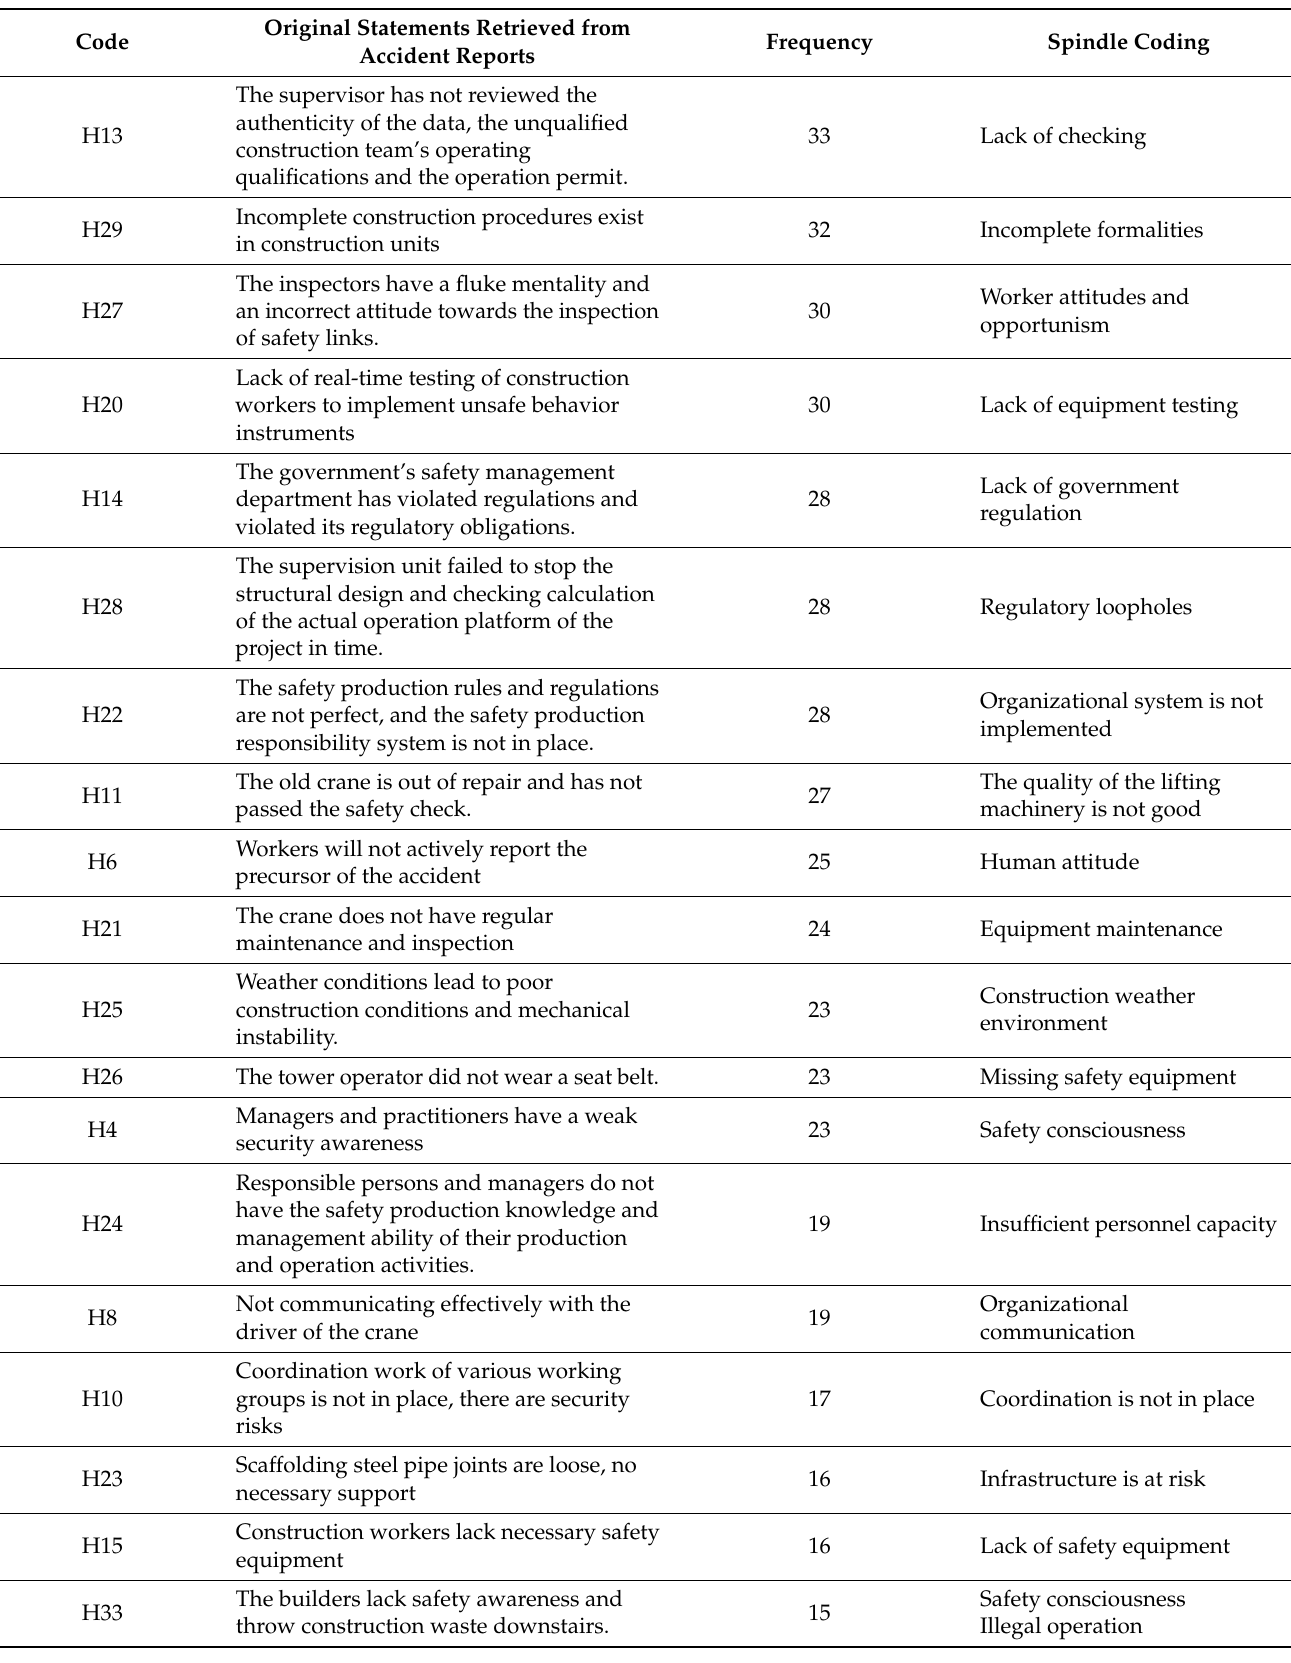
Table 2. The open coding with the identified spindle coding